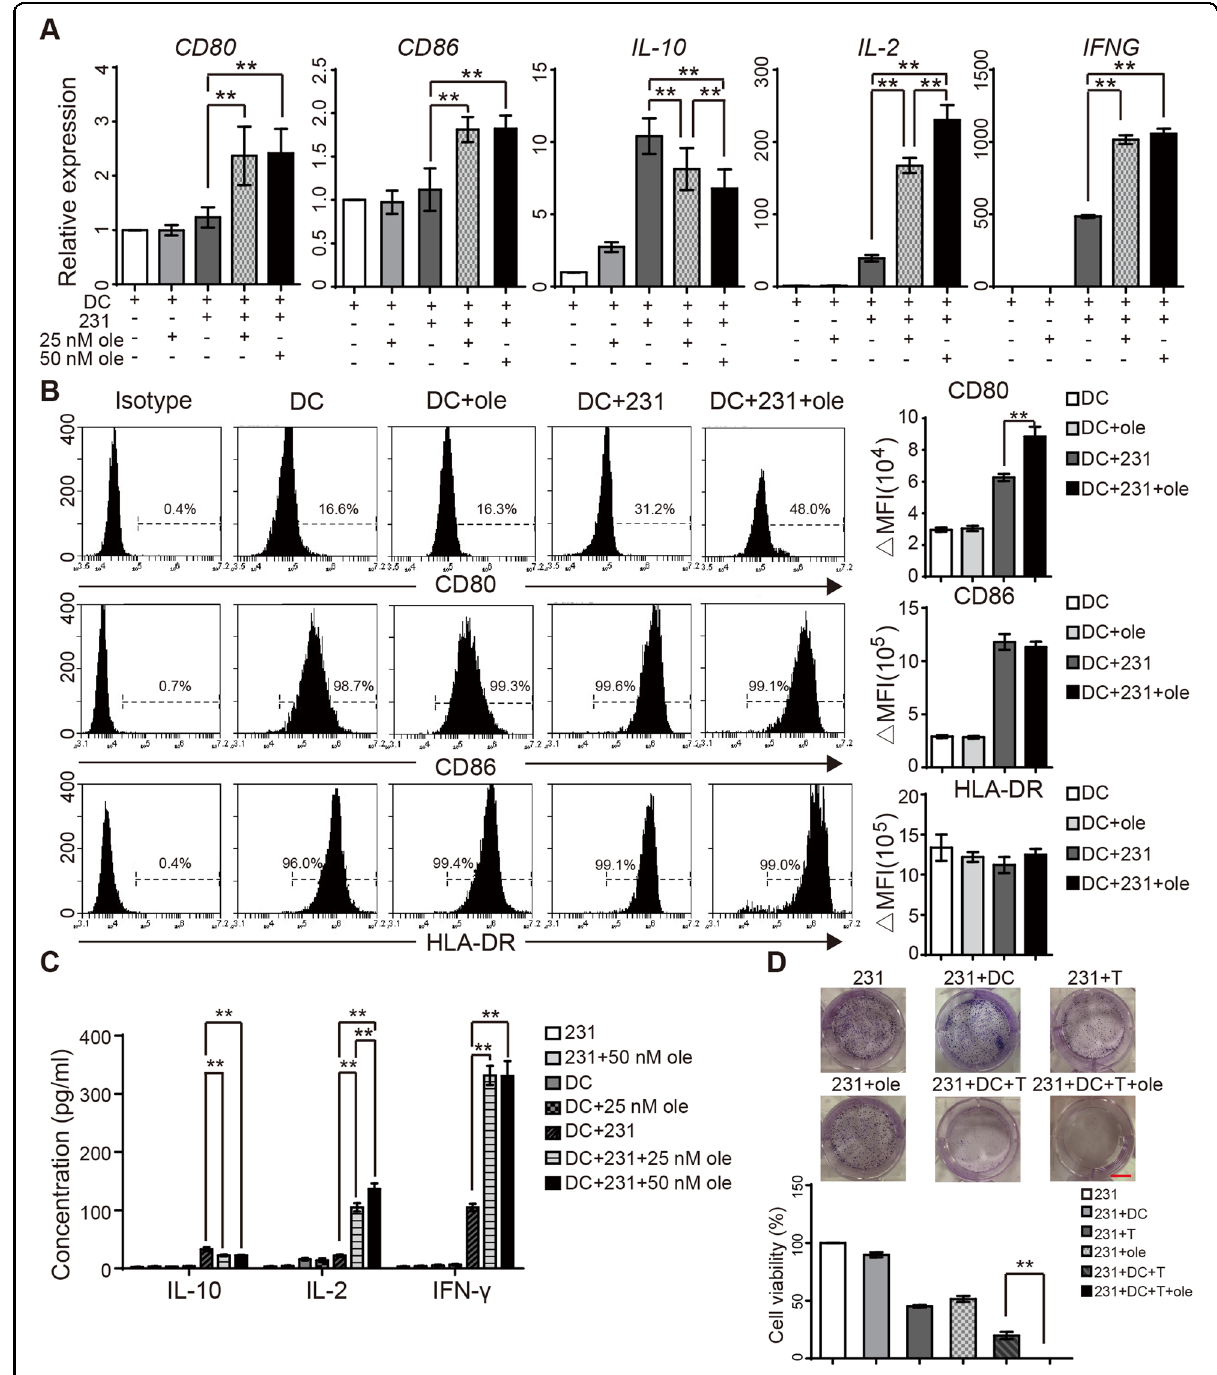
Fig. 3 Oleandrin induces ICD-associated immune activation in vitro. DCs were co-cultured with MDA-MB-231 with or without oleandrin treatment for 48 h. DCs were sorted by staining with CD45. A The relative expression of CD80 , CD86 , IL-10 , IL-2 , and IFNG in DCs were detected by qRT-PCR. B The expression of CD80, CD86 and HLA-DR on DCs surface were further detected by fl ow cytometry. Cells stained with isotype antibody were used as control. Data were represented by Δ MFI values. C MDA-MB-231 cells were pretreated with oleandrin for 24 h and co-cultured with DCs for further 48 h. Cytokine secretion in the culture supernatant was detected by ELISA. D The cell growth of the following groups was determined by clone-formation assay: MDA-MB-231, MDA-MB-231/DCs, MDA-MB-231/CD8 + T cells, MDA-MB-231/DCs/CD8 + T cells, 25 nM oleandrin-treated MDA- MB-231, and 25 nM oleandrin-treated MDA-MB-231/DCs/CD8 + T cells. The representative pictures (upper) and quanti fi cation data (lower) were shown. Data are presented as mean ± standard error of the mean from three independent experiments. ** p < 0.01. 231, MDA-MB-231; ole, oleandrin.